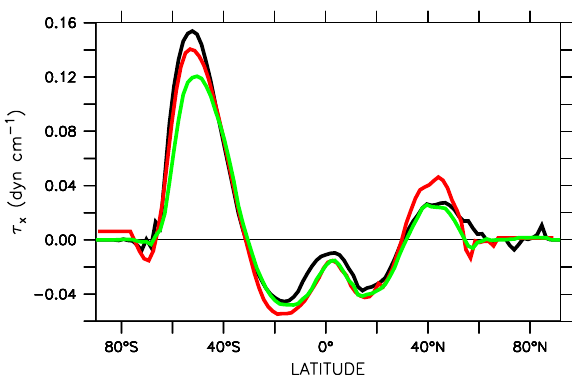
Fig. 7. Zonally averaged annual-mean zonal wind stress (in dyncm − 1 ) for the standard model employing the NCEP/NCAR cli- matology (black), the CORE forcing (Large and Yeager, 2004) av- eraged over the period 1958–2007 (red) and the CORE forcing av- eraged over 1958–1967